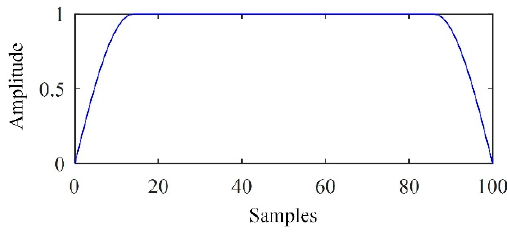
Figure 3. Waveform of a Turkey-Hanning window.